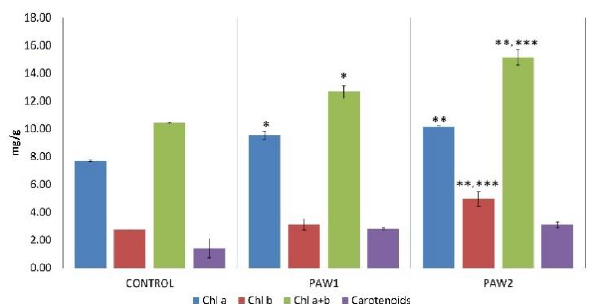
Figure 5. Effect of PAW treatment on the photosynthetic pigments content in Triticum aestivum L. cv. Glosa shoots at day 8 ; * significant difference ( p < 0.05) between control and PAW1; ** significant difference ( p < 0.05) between control and PAW2; *** significant difference ( p < 0.05) between PAW1 and PAW2. Each point represents the mean ± SD of three determinations.